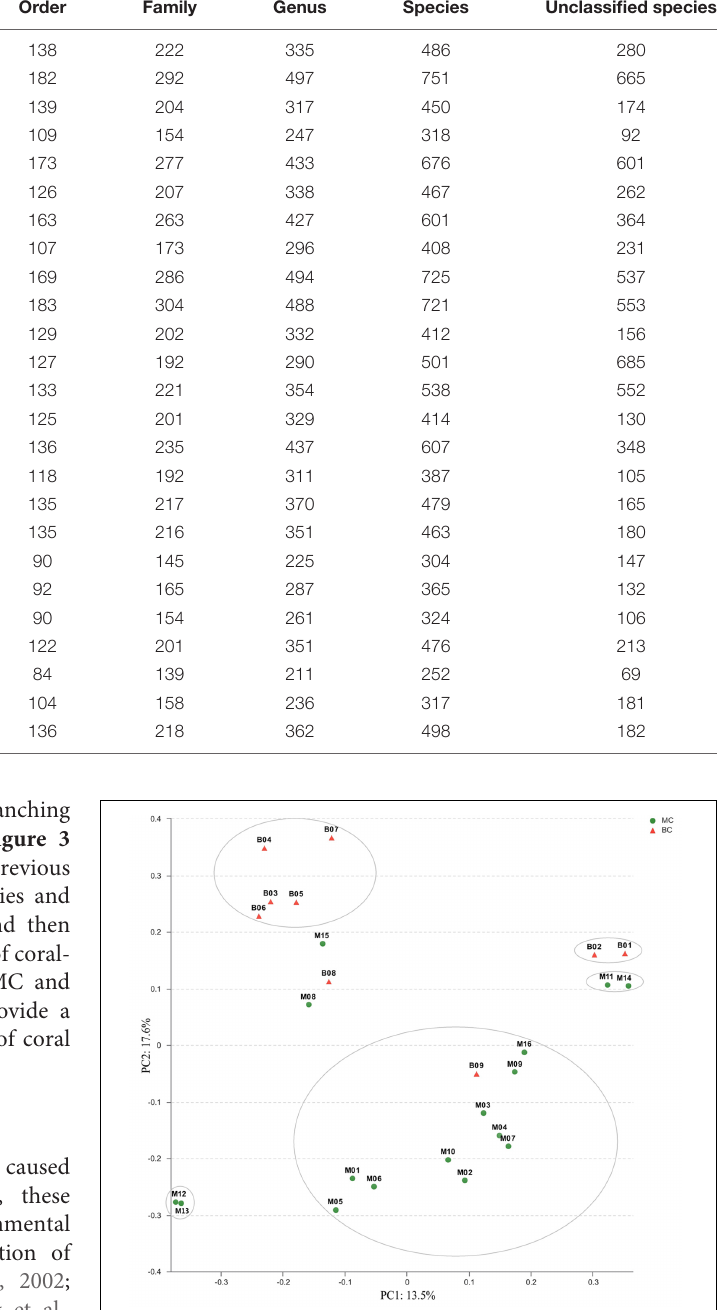
libraries in this study. This suggests that these corals are less likely to be threatened by common bacterial diseases in this sea area. Sharon and Rosenberg (2010) indicated